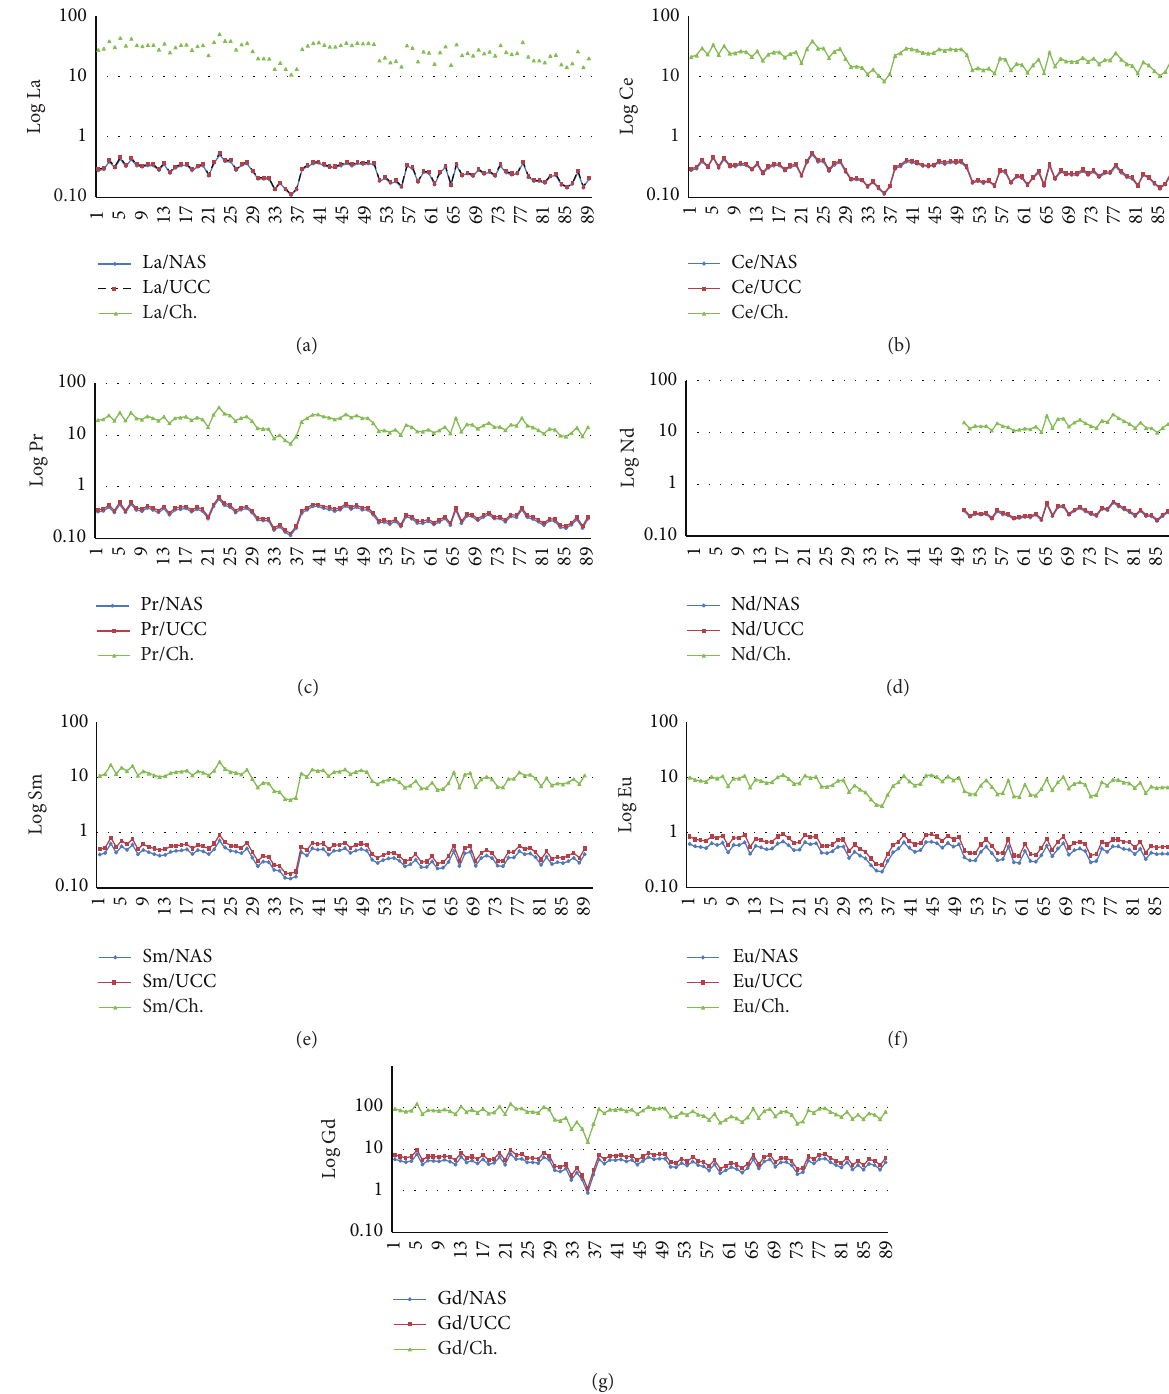
Figure 3: Normalized patterns of the LREE average concentrations ( 𝑁 = 90 ) of Euphrates River sediments in the NAS, UCC, and Ch. (a) La, (b) Ce, (c) Pr, (d) Nd ∗ ( 𝑁 = 50 ), (e) Sm, (f) Eu, and (g) Gd normalized patterns.